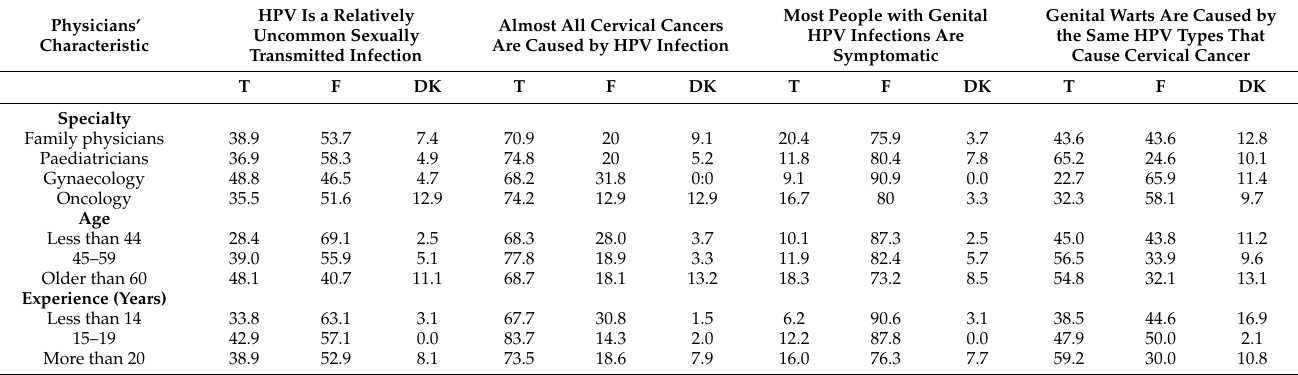
Table 1. Knowledge of HPV of physicians practicing different specialist